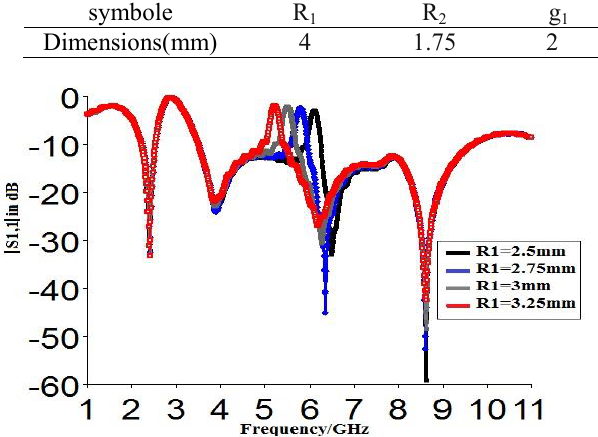
Table :3 optimal parameters values of Compelementary split ring resonator.